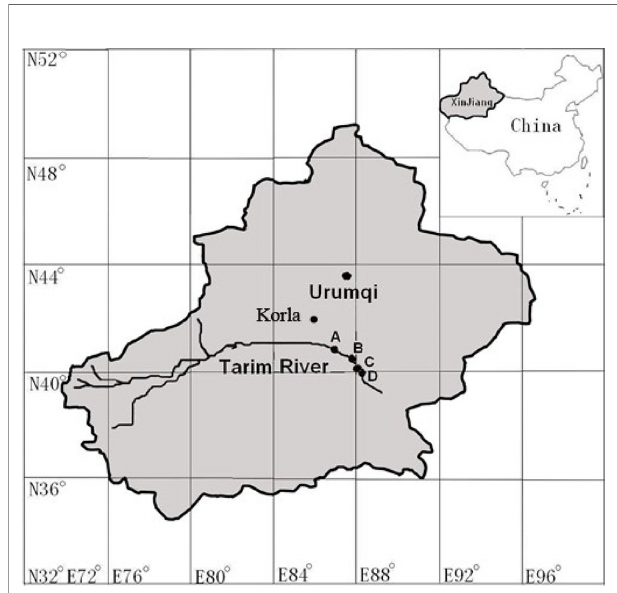
FIGURE 1 | Geological locations of the four studied sites. Site name: A = 31 Tuan, B = 33 Tuan, C = Yingsu, D =